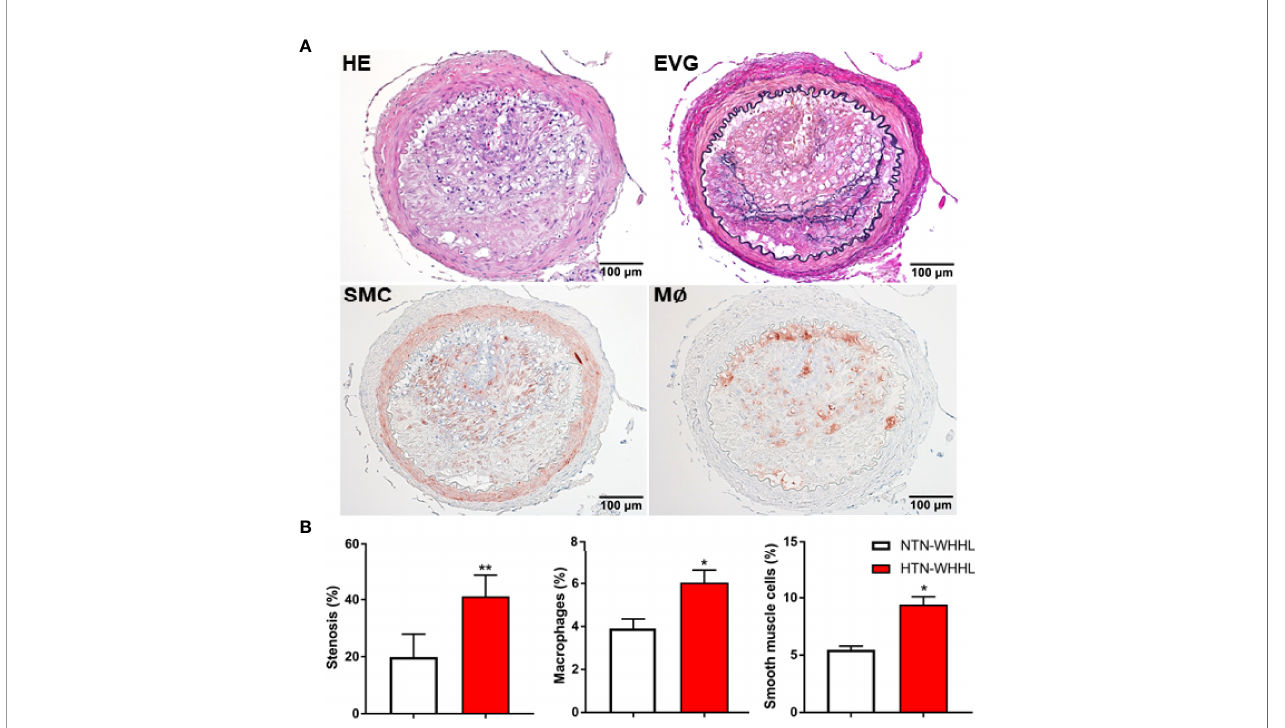
FIGURE 5 | Representative micrographs of intracranial atherosclerosis of WHHL rabbits with renovascular hypertension (A) . Renovascular hypertension was induced at 8 mon and systolic and diastolic pressure was maintained at 160 mm Hg (110 mm Hg in control) and 110 mm Hg (100 mm Hg in control) for 12 mon (25). Normotensive group was subjected to a sham operation and used as controls. Serial sections were stained with hematoxylin-eosin (HE) and elastica van Gieson (EVG) or immunohistochemically stained with antibodies against either macrophage (M ∅ ) or smooth muscle cells (SMC). The lesions of the vertebral arteries of a hypertensive WHHL rabbit are almost occlusive and rich in macrophages. Lumen stenosis rate, macrophages and smooth muscle cells in the lesions (n= 14 for hypertensive and n=4 for normotensive) were quanti fi ed and expressed as % (B) . *p<0.05, **p<0.01 vs. normotensive. Actual areas were shown in Supplemental Data ( S-Table 6